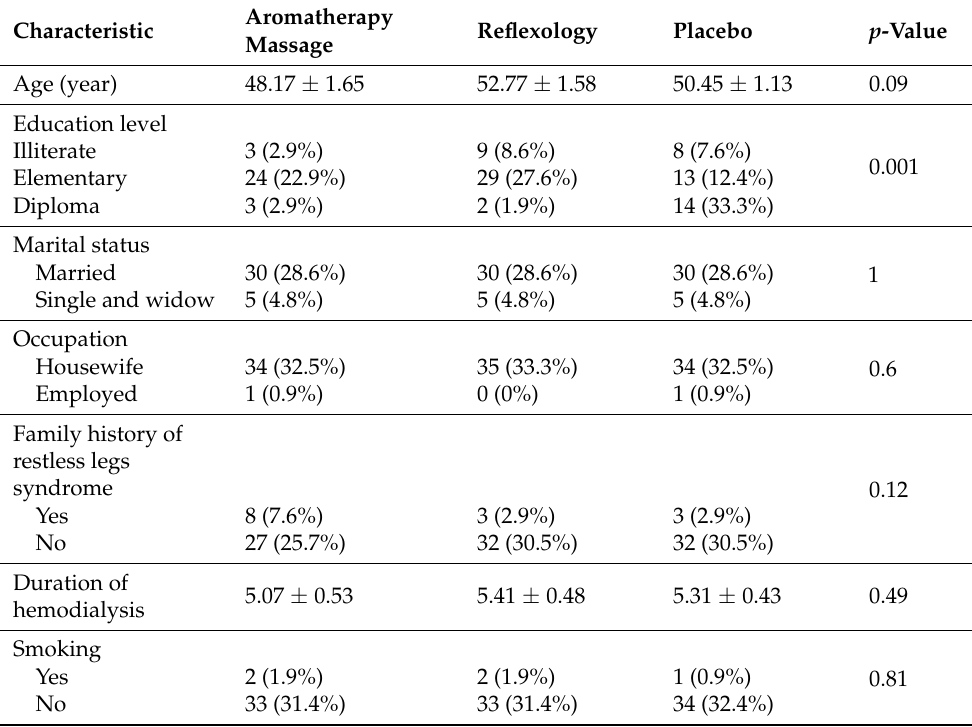
Table 1. Demographic characteristics of the patients in the groups.